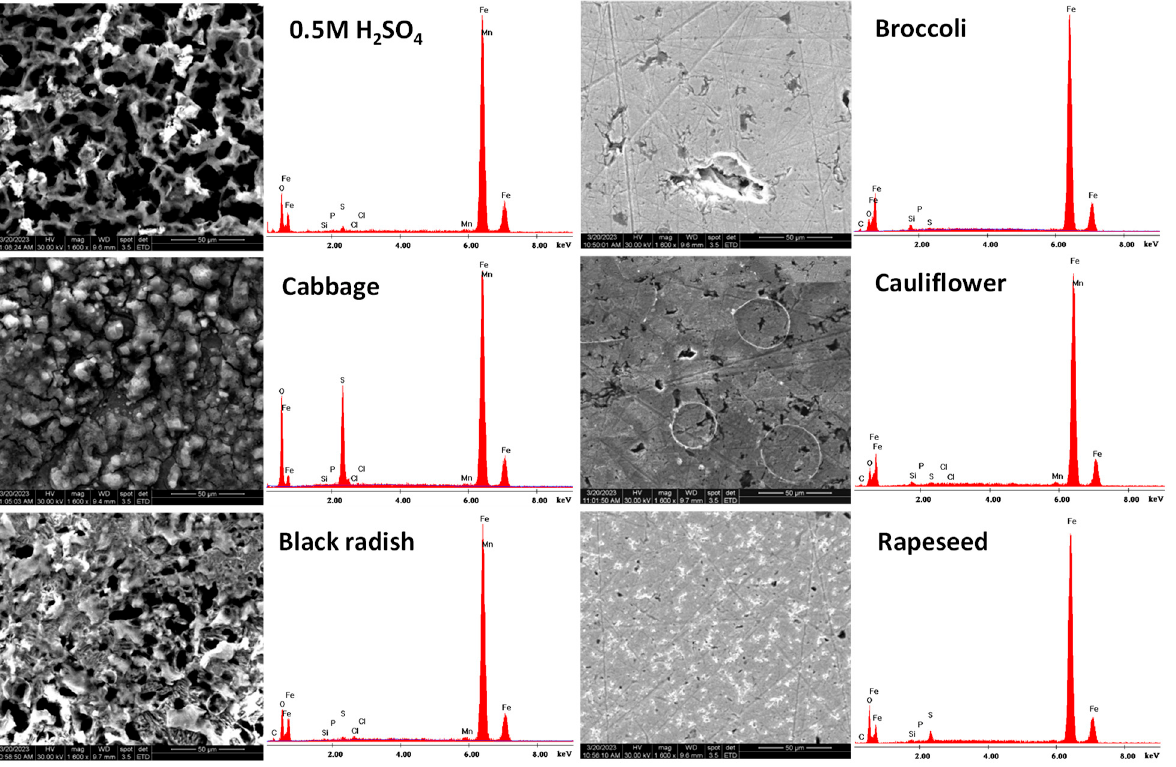
Figure 6. SEM images/EDX spectra of the steel surface after the weight-loss experiments, with and without extracts A. Table 6. Percentage of atomic contents of elements obtained from EDX spectra.